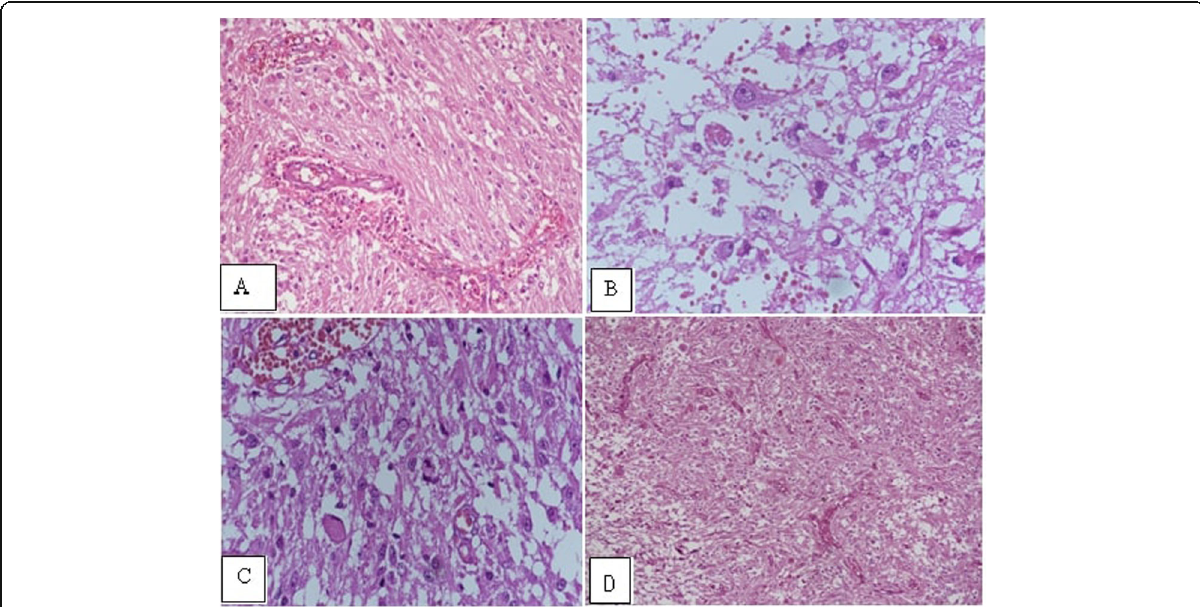
Fig. 2 Photomicrograph showing a branching capillaries and eosinophilic granular bodies seen in a fibrillary glial background. H&E, × 100. b Ganglion cells with vesicular chromatin, prominent nucleoli, and moderate to abundant amount of eosinophilic cytoplasm. H&E, × 400.